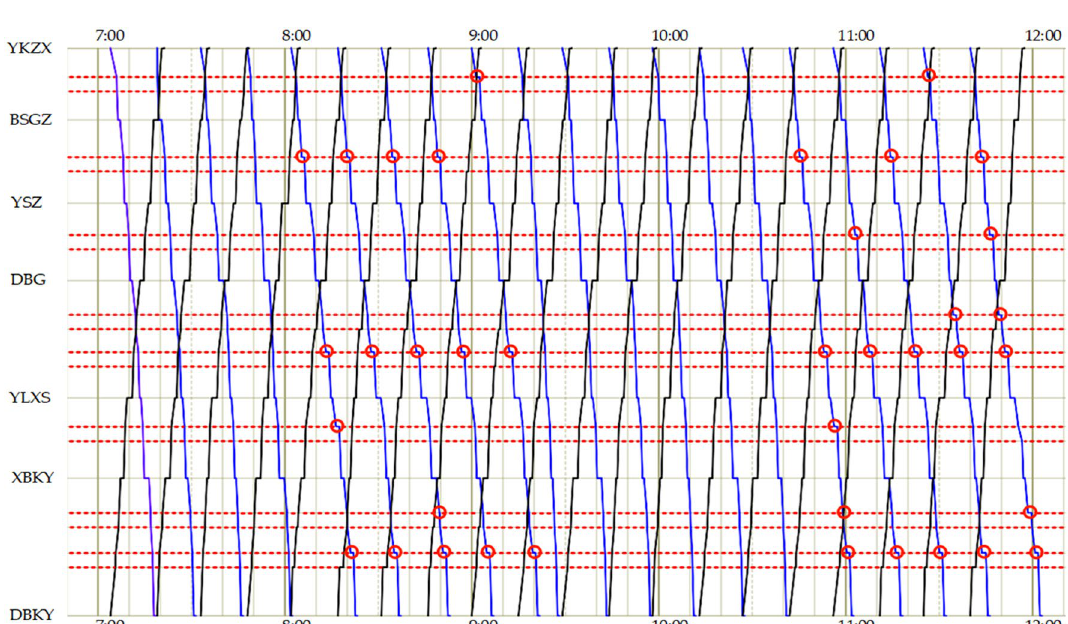
Figure 7. The tram timetable of comprehensive optimization scheme (this